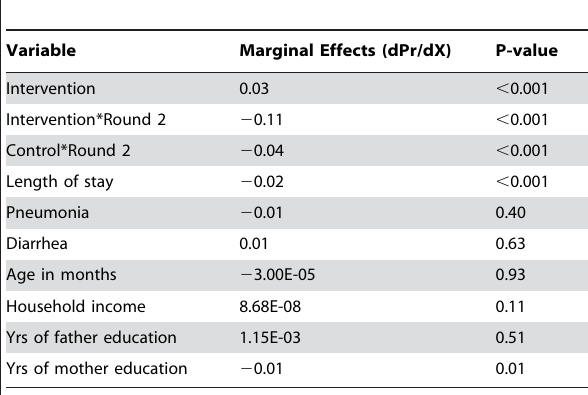
Table 2. Logit model of insurance underutilization for children admitted to hospital with PhilHealth